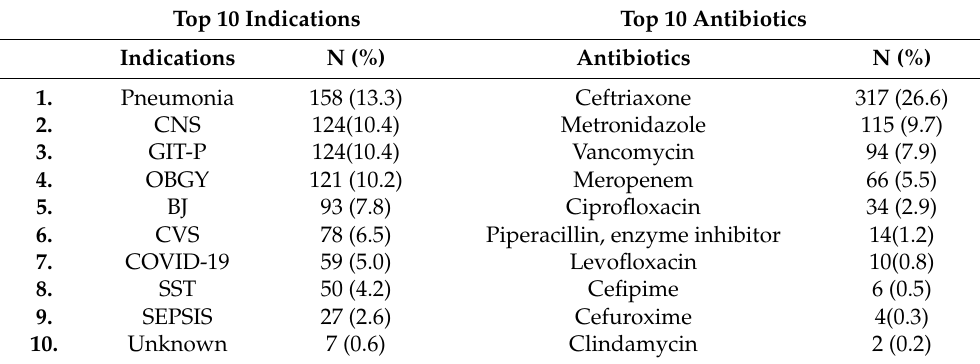
Table 3. Top 10 indications and